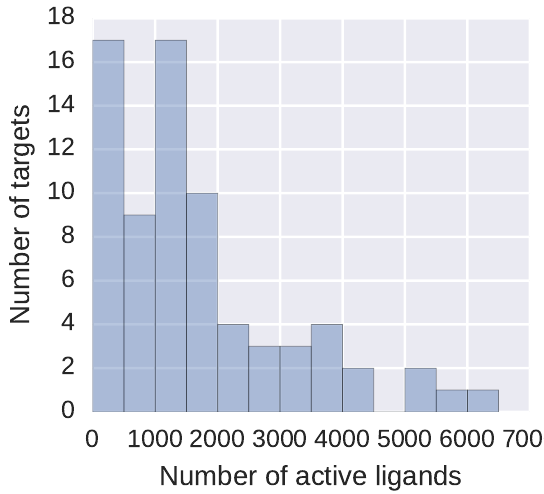
Figure 2. Number of active ligands in the SEA based activity prediction dataset. The dataset consists of 73 targets from diverse protein families, with a mean of 1680.05 active ligands per target (SD: